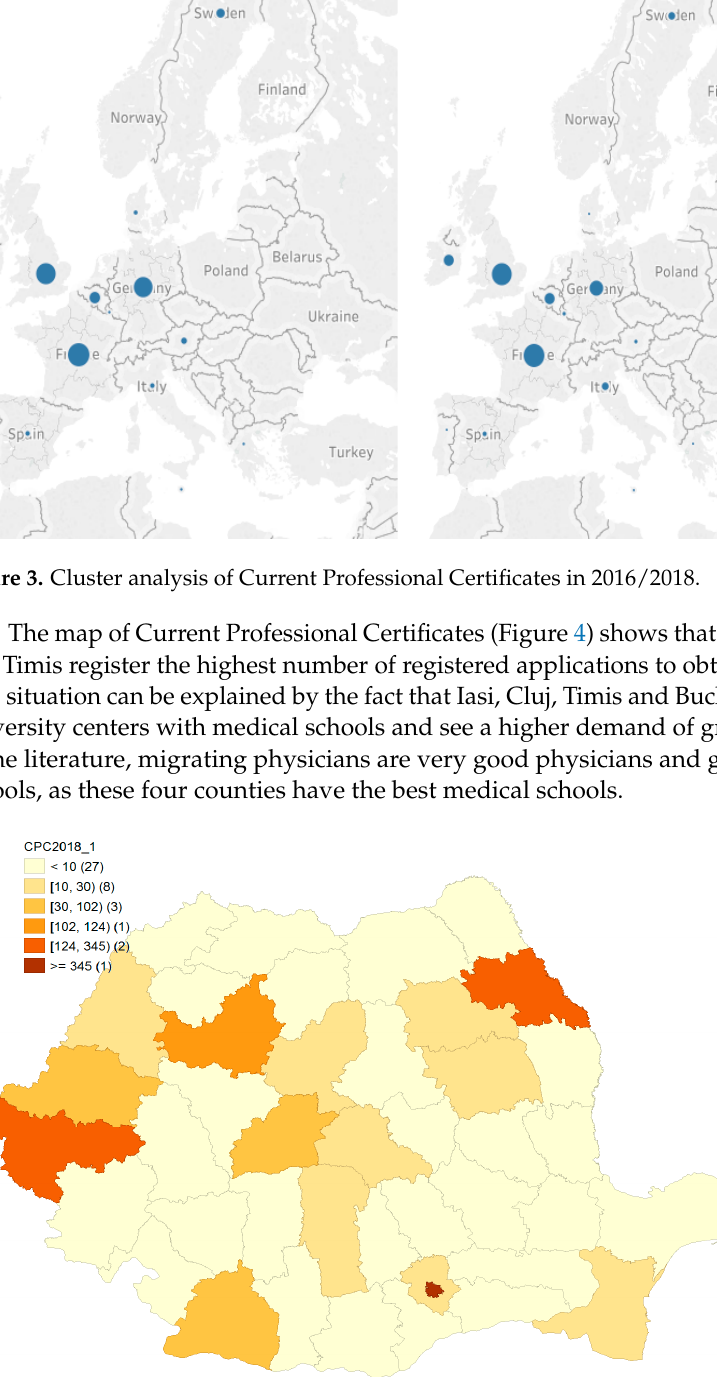
Figure 4. The map of CPC, 2018.